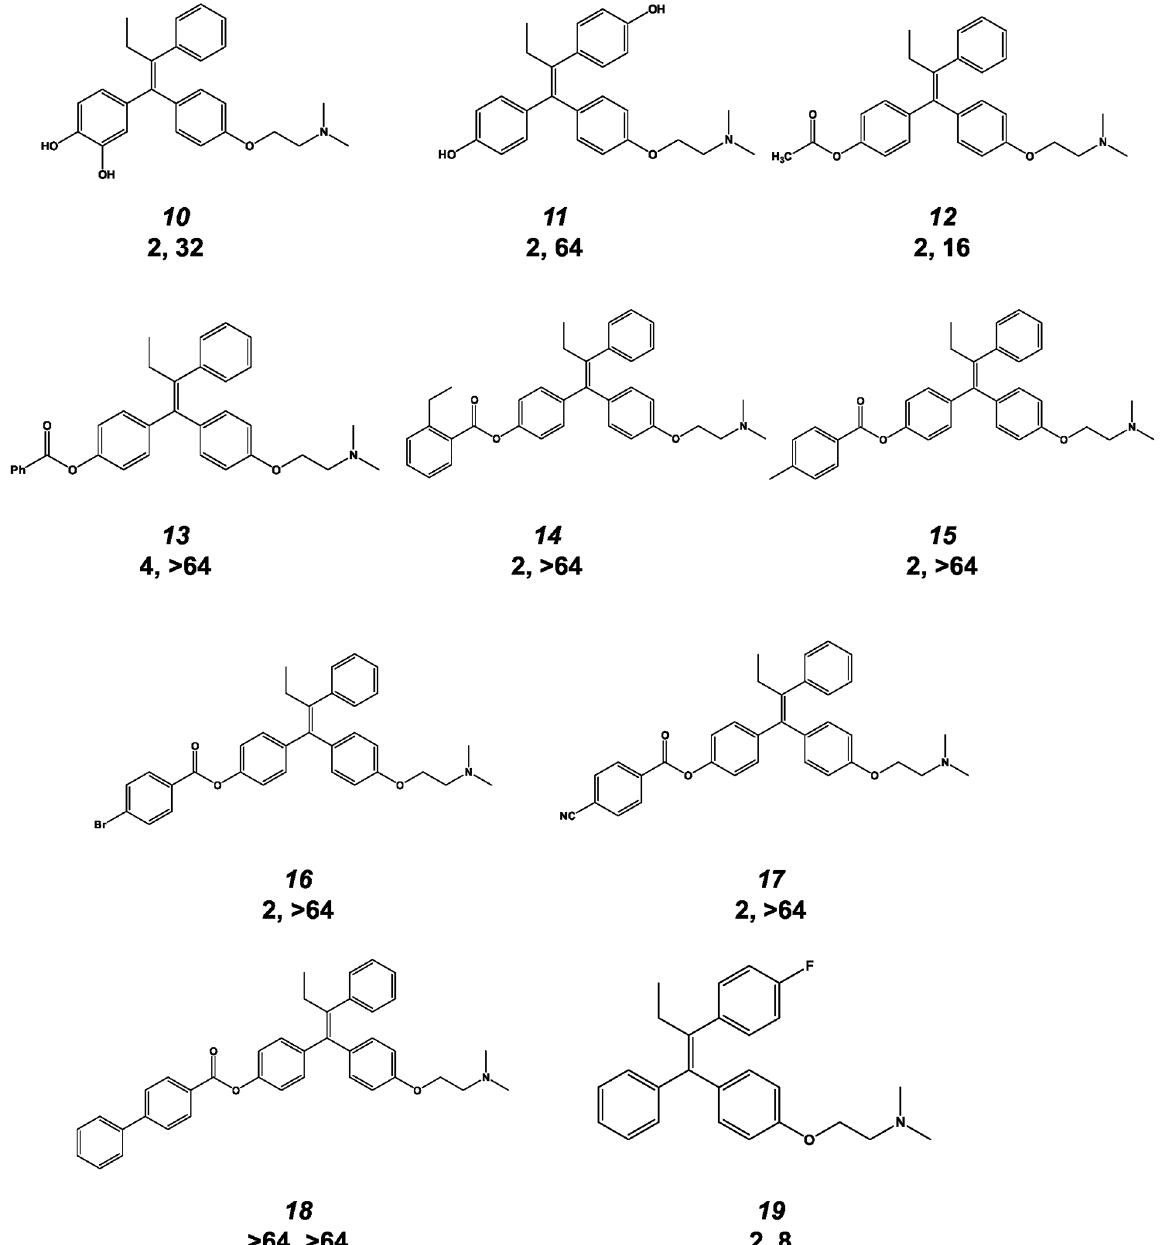
Fig 3. Antifungal activity of aryl-ring substituted tamoxifen derivatives. The structure, molecule number used in the text, minimum inhibitory concentration (MIC, μ g/mL) against C . neoformans (first number) and MIC against C . albicans are provided.